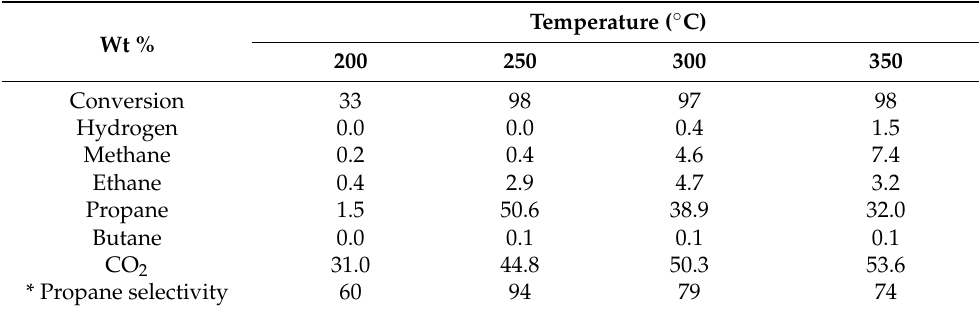
Table 4. Butyric acid conversion and product yields under compressed air atmosphere at different